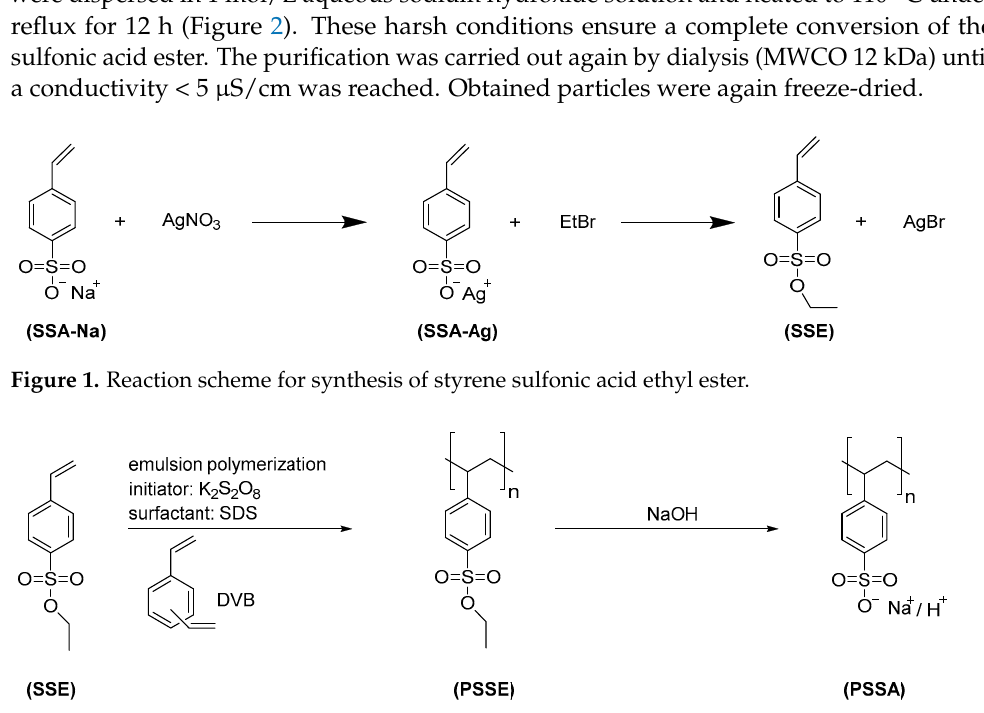
Figure 2. Reaction scheme for synthesis of the particles via emulsion polymerization of SSE and DVB initiated by KPS in an aqueous SDS solution, followed by saponification of the sulfonic acid ester (“deprotection” of ion exchange groups).